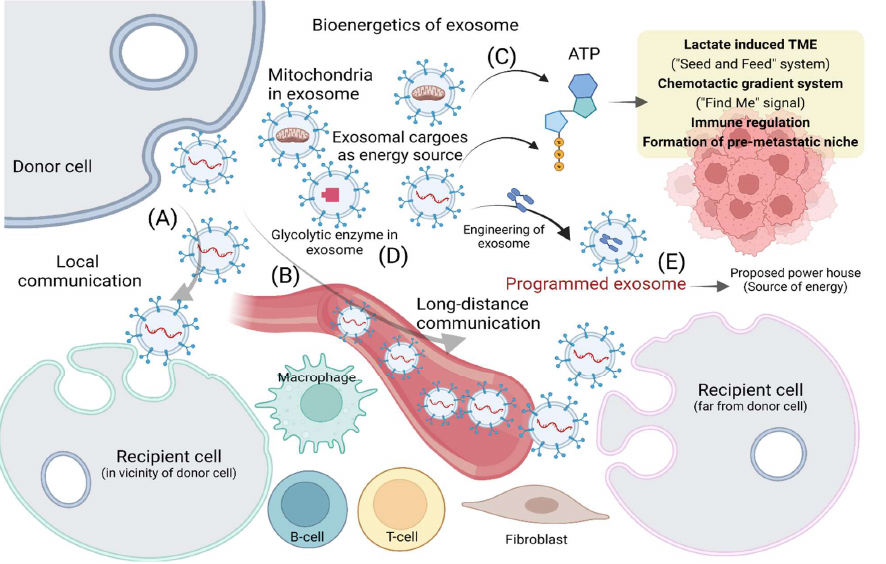
Figure 1. Bioenergetics of exosomes for cell–cell communication in the tumor microenvironment (TME): ( A , B ) local or long-distance exosomal communication in TME; ( C , D ) the presence of mito- chondria in exosomes, the release of extracellular ATP by exosomes, and the existence of glycolytic enzymes in the proteomics of exosomes provide evidence for possible energy source; ( E ) pro- grammed exosomes can be developed through engineering as a potential powerhouse. Figure cre- ated with BioRender. Donor cell release of exosomes requires a huge expenditure of both energy and bio- synthetic materials. Various types of cargo of exosomes involved in bioenergetics are listed in Table 1. In particular, cancer cells release a tremendous number of exosomes com- pared with normal cells and regulate the immune response [50]. The generation of ATP by exosomes can be attributed to various needs such as immunoregulation and commu- nication with stromal cells in the TME (Figure 1C). This leads to several advantages, in- cluding the production of extracellular ATP, the formation of a lactate induced TME, the establishment of a seed-and-feed system in the TME, and the creation of a long-range chemotactic gradient system or “find me” signal. ATP generated from tumor exosomes may have various effects in cancer, including regulation of the immune system. The aug- mented amount of ATP in the TME enhances the production of extracellular adenosine, a strong immunoregulator, and facilitates the immune evasion process in tumors [51]. The extracellular ATP has also been found to play roles in the uptake of exosomes in the TME and the communication of cancers cells with stromal cells via exosomes [15,24]. In the TME, the production of glycolytic ATP can reduce the glucose level while enhancing the lactate level, because exosomes have been found to contain lactate dehydrogenase (LDH) which facilitates the transformation of glycolytic end product pyruvate to lactate [52,53]. Another aspect of the role of extracellular ATP is that it can be taken up by tumor cells, which is energetically favorable, leading to augmented intracellular levels of ATP. This suggests that the release of ATP-generating tumor exosomes can lay the foundation for a seed-and-feed system, where cancer cells can partially outsource their energy outside the cell [54]. Extracellular ATP has also been reported as a potent “find me” signal that is